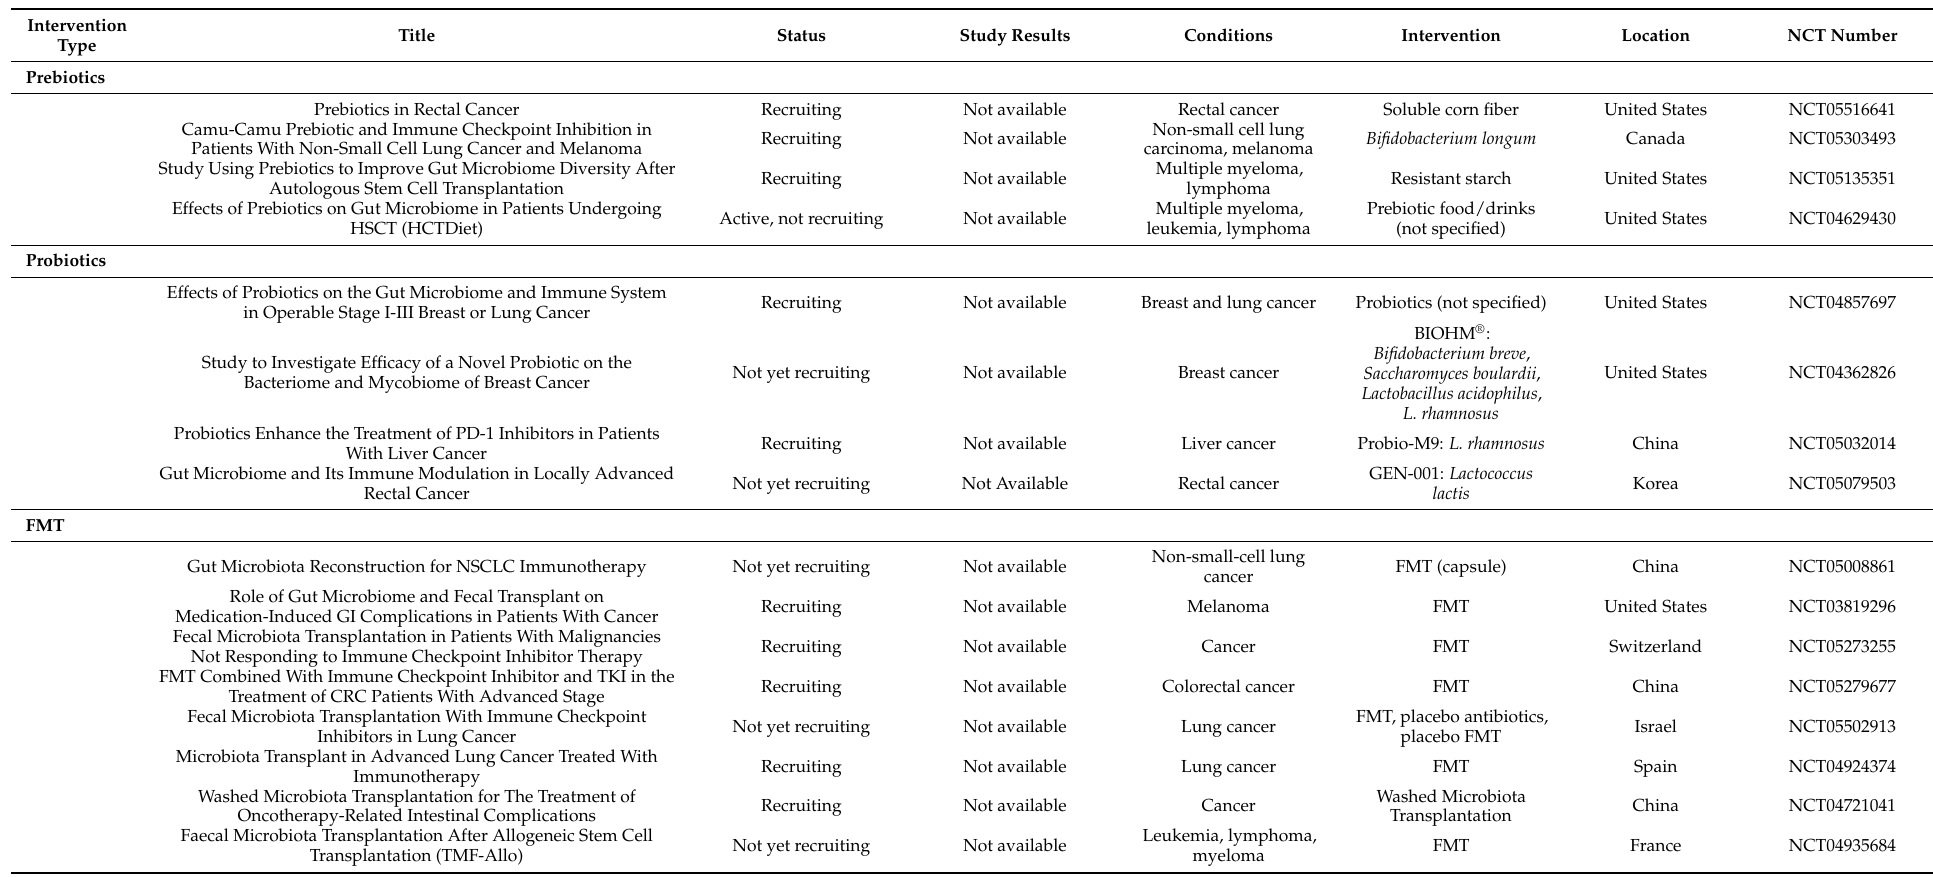
Table 1. Clinical trials registered on ClinicalTrials.gov (as accessed in 20 September 2022), started in the last two years and focused on the use of prebiotics, probiotics, fecal microbiota transplantation, or antibiotics for the adjuvant treatment of cancer. Search terms included “gut microbiome”, “prebiotics”, “probiotics”, “fecal microbiota transplantation”, “antibiotics”, and “cancer”. CRC: colorectal cancer; FMT: fecal microbiota transplantation; FOS: fructo-oligosaccharides; GI: gastrointestinal; GOS: galacto-oligosaccharides; HSCT: hematopoietic stem cell transplantation; NSCLC: non-small cell lung carcinoma; PD-1: programmed